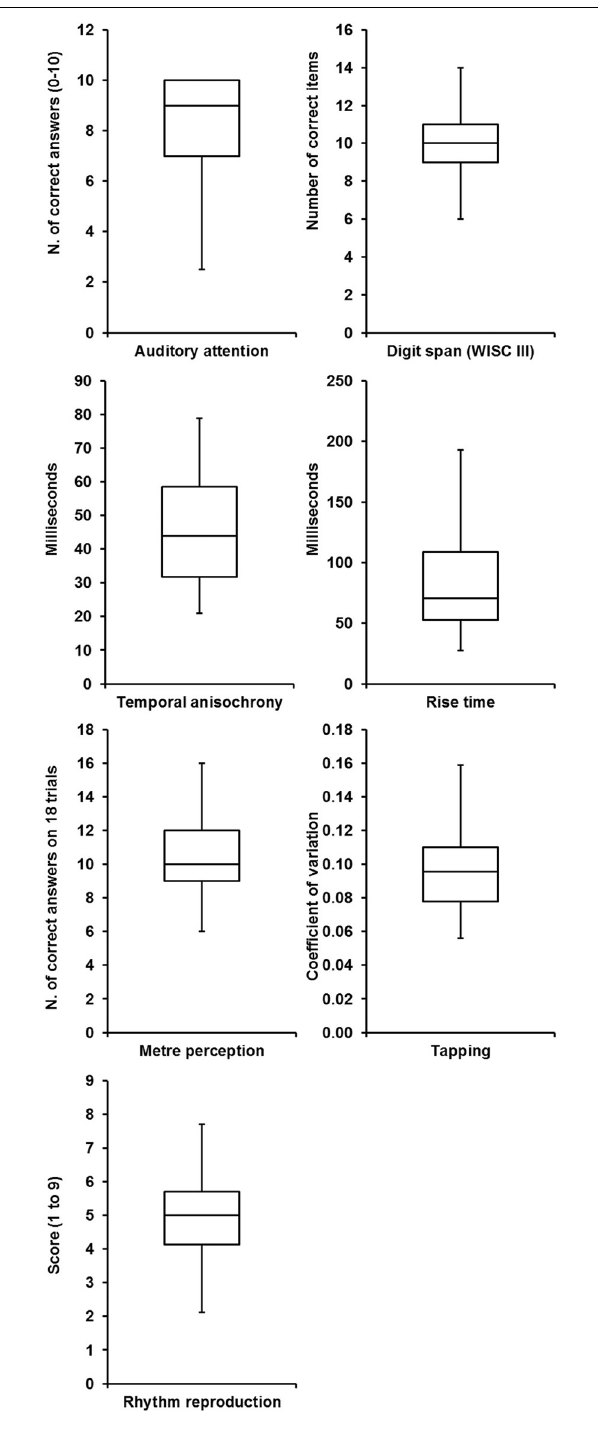
FIGURE 3 | Box plots of the temporal processing measures.